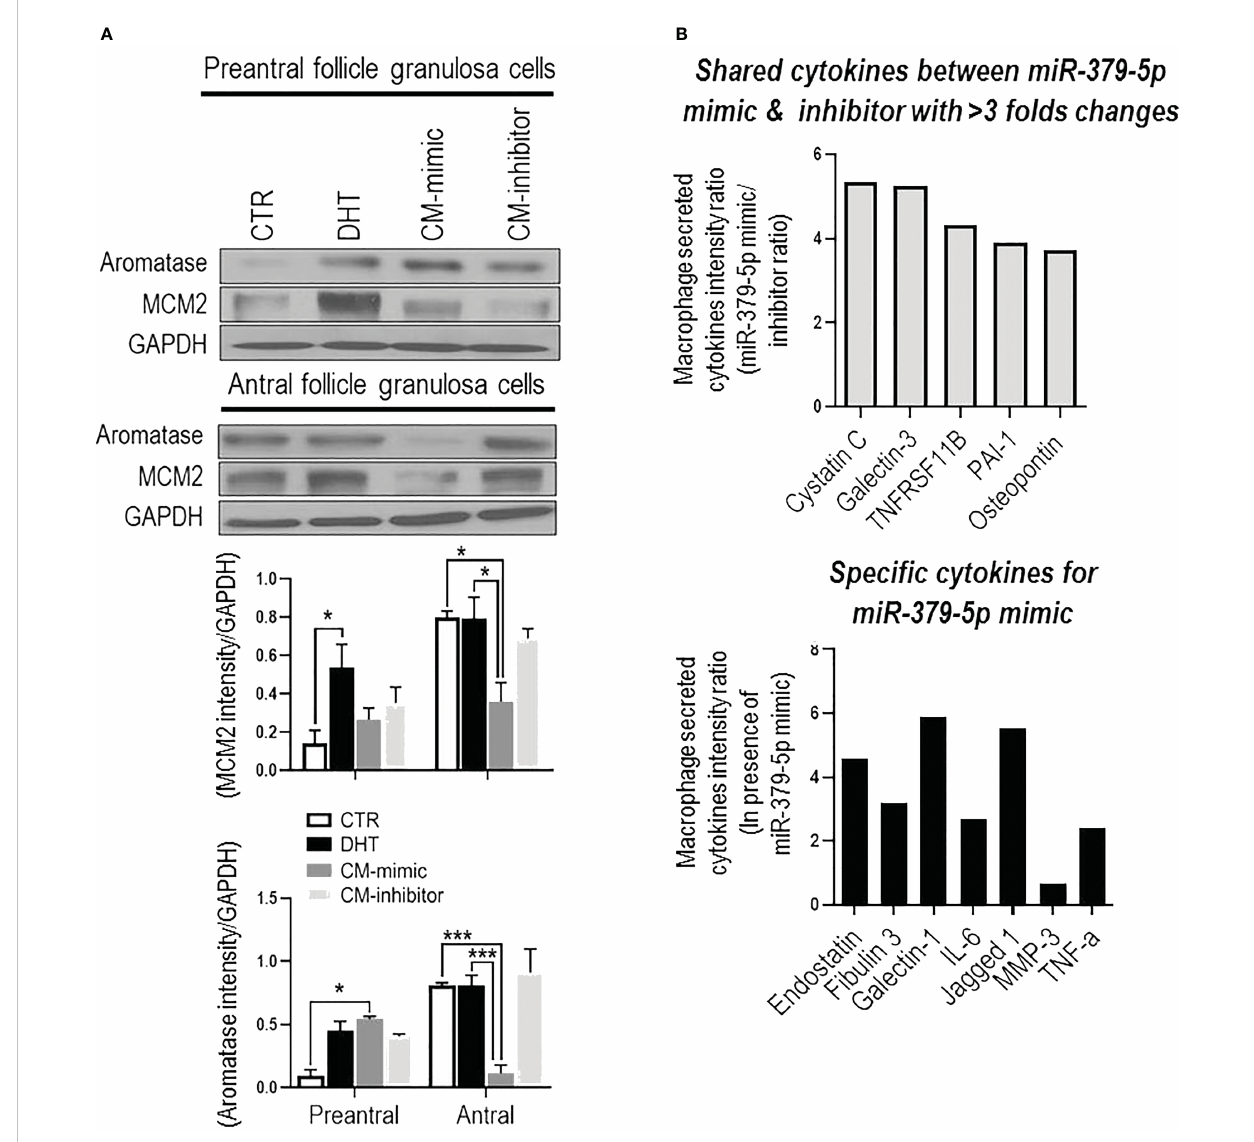
FIGURE 2 MiR-379-5p-induced M1 polarization regulates granulosa cell proliferation in a follicular stage-speci fi c manner by increasing pro-in fl ammatory cytokine level. (A) Conditioned media from macrophages transfected by miR379 mimic (CM-mimic) increases aromatase content without affecting proliferation in preantral follicle GC, while it reduces aromatase and proliferation in that of antral follicles. The aromatase and proliferative responses were not signi fi cantly in fl uenced by the presence of the CM-inhibitor compared to control in both follicle stages; (B) Pro fi le of cytokines (Proteome Pro fi ler Rat XL Cytokine Array; R&D Systems) in macrophage condition medium indicates that CM-mimic had higher content of in fl ammatory cytokines, including Cystatin C (5.4 fold), Galectin-3 (5.3 fold), TNFRS11B (4.3 fold), PAI-1 (3.9 fold) and Osteopontin (3.7 fold). In addition, Endostatin, Fibulin 3, TNF- a , Galectin-1, IL-6, Jagged 1 and MMP3 were speci fi c cytokines to CM-mimic. Results are expressed as mean±SEM (n=3 replicates each with 2 rats/group). Data were analyzed by two-way ANOVA and tukey post hoc. * P <0.05, *** P